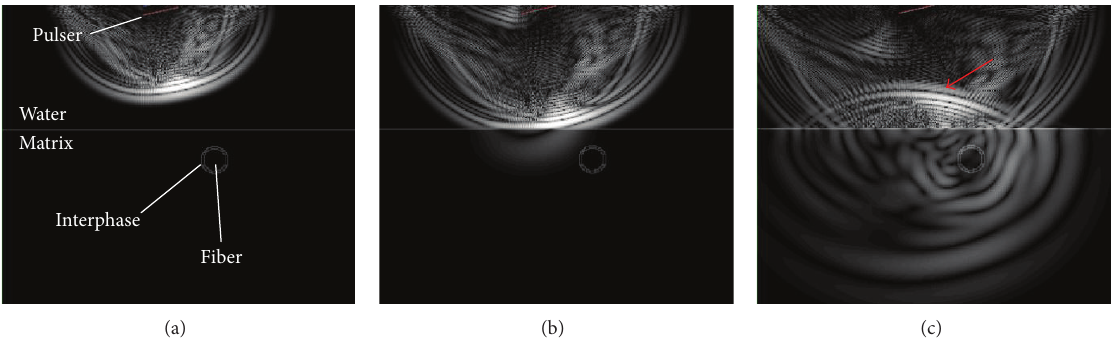
Figure 5: Consecutive snapshots of the displacement field for the case of stiff interphase.